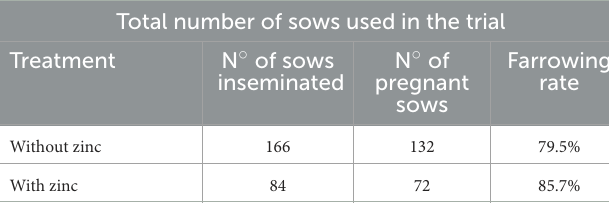
TABLE 4 Percentage of pregnant sows upon AI performed using sperm preserved in extender with 2mM of ZnCl 2 and without ZnCl 2 . Total number of sows used in the